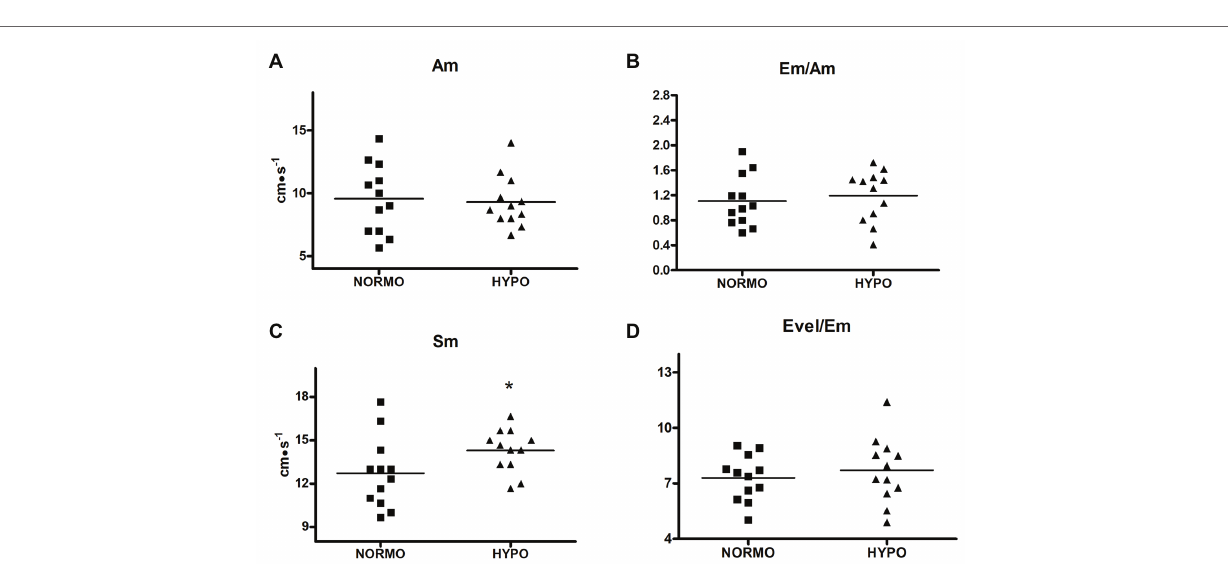
FIGURE 4 | Scatter plot graphs of levels of late diastolic mitral valve motion velocity (Am, panel A ), ratio between early and late diastolic mitral valve motion velocities (Em/Am, panel B ), systolic myocardial velocity (Sm, panel C ), and ratio between early transmitral filling peak and early mitral valve diastolic velocities (Evel/ Em, panel D ) during the recovery from sessions of exercise in normoxia (NORMO) and in normobaric hypoxia with a FiO 2 of 13.5% (HYPO). N = 12. * p < 0.05 vs. NORMO